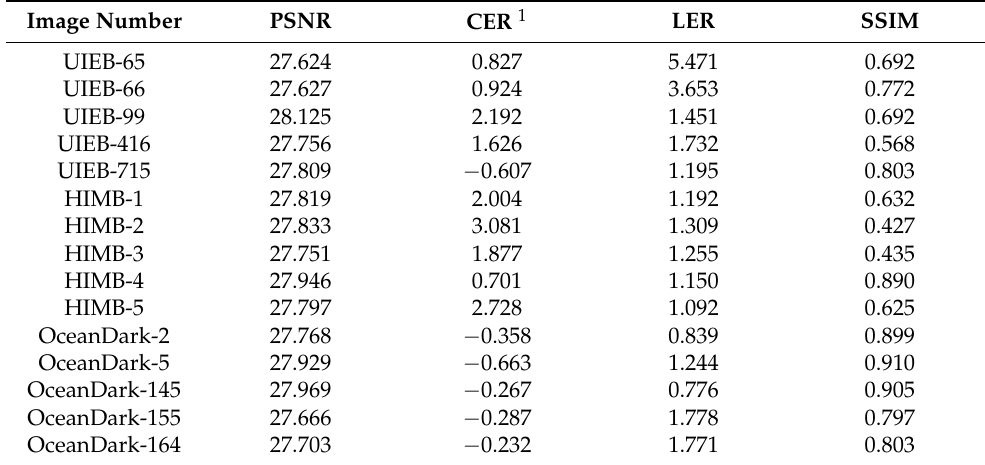
Table 2. Quantitative evaluation results on the datasets.